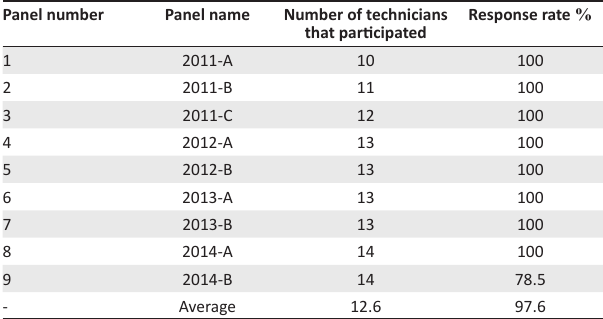
TABLE 1: Overall number of technicians that participated in the National External Quality Assessment Program for polymerase chain reaction of HIV DNA across the nine panels, Mozambique,